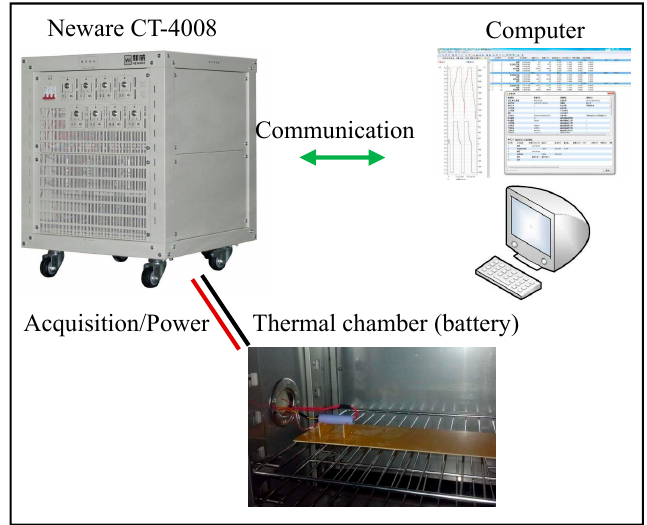
Figure 1. Schematic of the battery test bench.